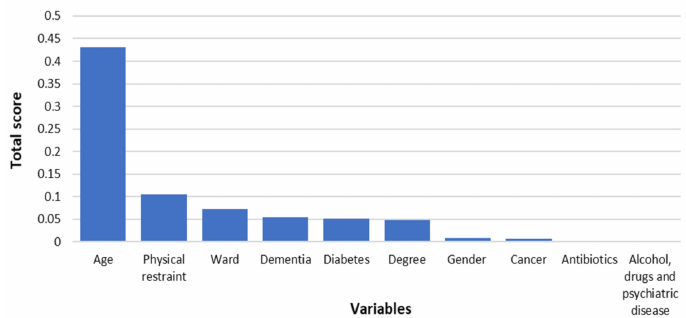
Figure 2. Variables with top importance selected by the RF algorithm according to the permutation approach. The total score measures the predictive impact of the variables, i.e., the relative decrease of the algorithm’s predictive error produced by a variable.